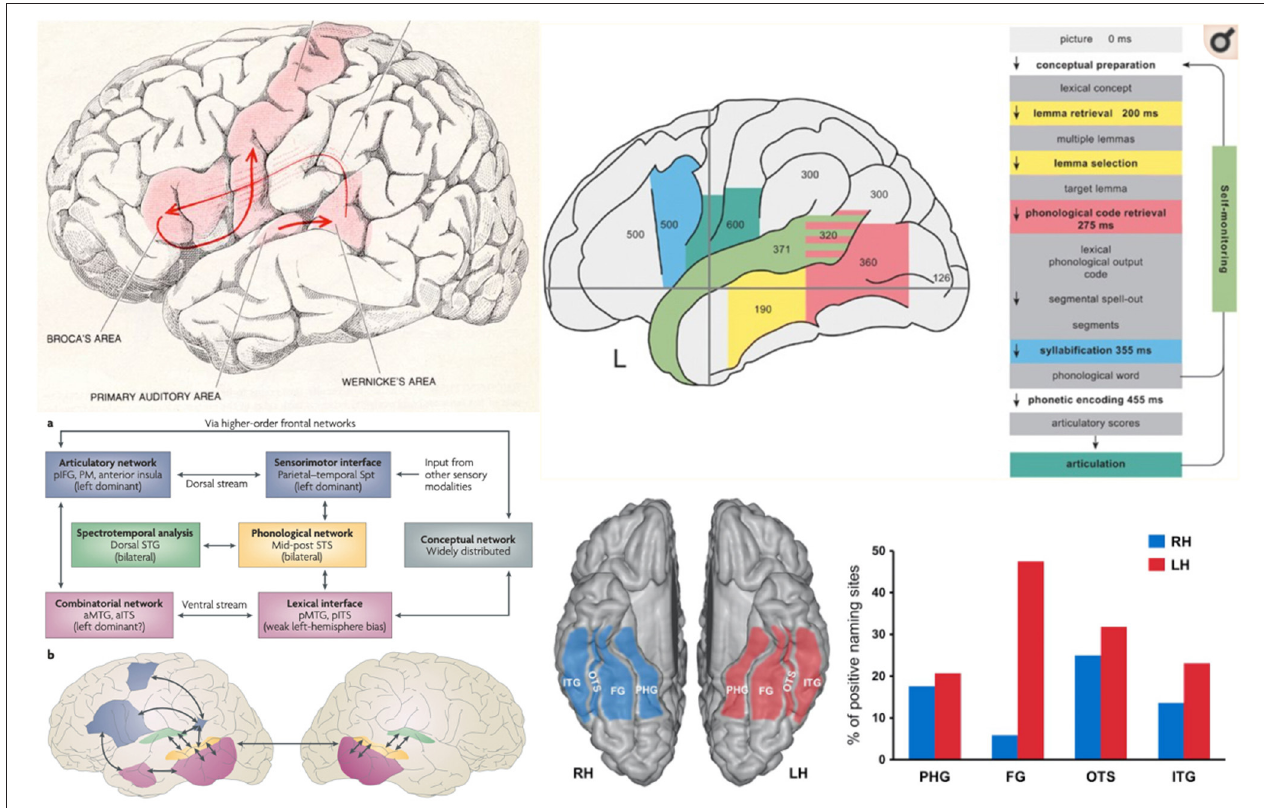
FIGURE 5 | Models and Anatomy of Language Networks reveal the large area of the cerebral cortical involved in language. Top left: Geschwind’s (169) illustration of the Broca-Wernicke model of language. Top right: Indefrey’s (170) model of cortical activity (showing evoked potential latencies by region in milliseconds) during a confrontation naming task, demonstrating some of the cortical extent of language processing. Bottom left: Hickok and Poeppel ( 39) dual stream model of the cortical anatomy of auditory language comprehension and response where auditory processing is bilateral and involves bilateral superior temporal sulci and unimodal auditory cortex from which activity is conveyed to either a dorsal stream for, motor and articulatory analysis and phonological representation, vs. a ventral stream for lexical and conceptual representation (aITS, anterior inferior temporal sulcus; aMTG, anterior middle temporal gyrus; pIFG, posterior inferior frontal gyrus; PM, premotor cortex). Bottom right: From Ulvin et al. (125), showing the regions in which stimulation can result in specific naming deficits (“positive naming sites”), identifying the crucial role of the dominant fusiform basal temporal region in naming (ITG, inferior temporal gyrus; FG, fusiform gyrus; OTS, occipitotemporal sulcus; PHG, parahippocampal